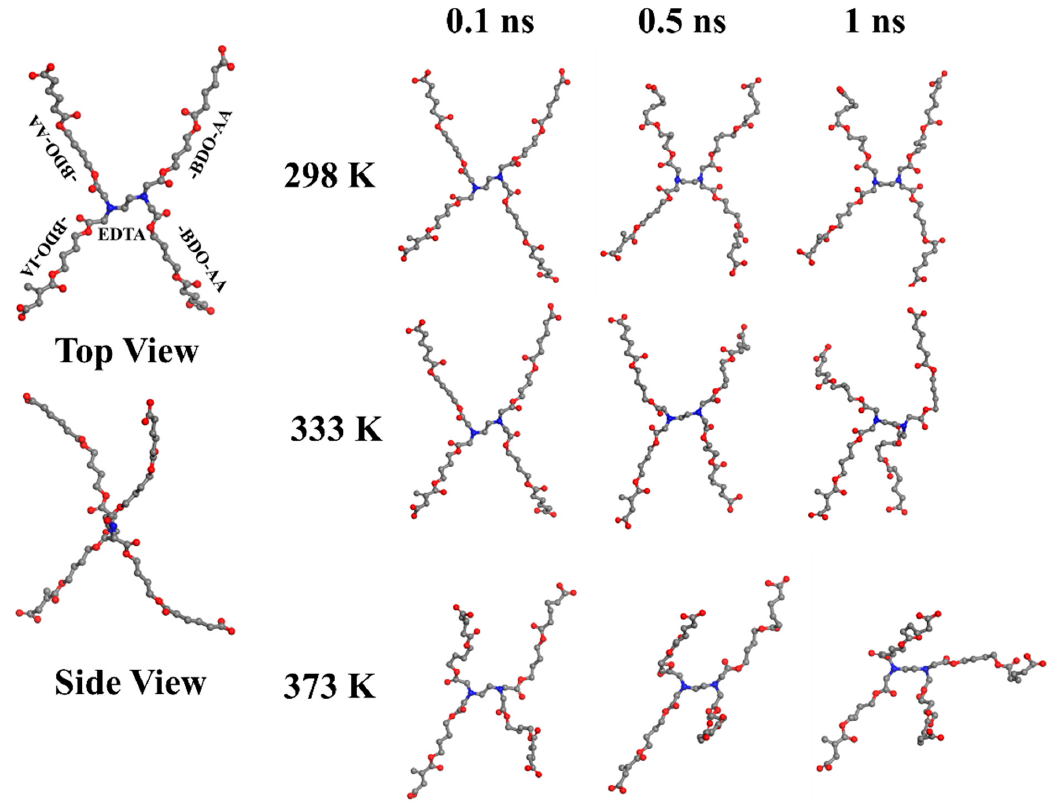
Figure 9. The structural deviation of the node point (EDTA-BDO-AA/IA) at various temperatures. (Color key—gray: carbon, red: oxygen, and blue: nitrogen, white: hydrogen (emitted)).